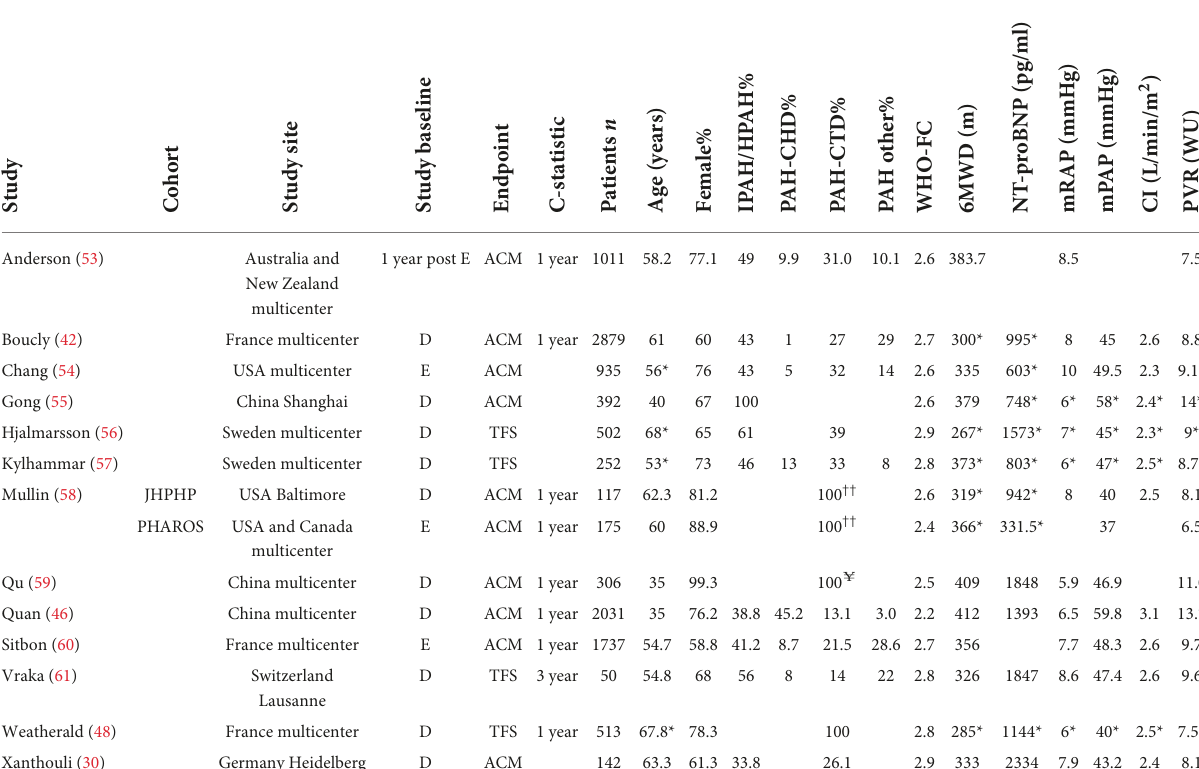
TABLE 2 Study characteristics of studies describing model